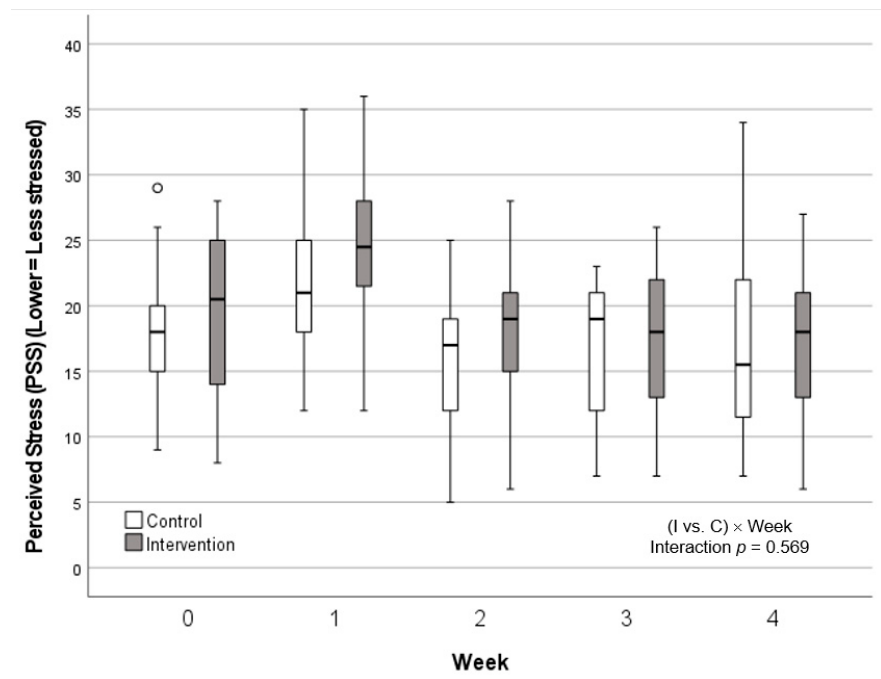
Figure 2. Perceived stress scores over time by group. For professional quality of life, boxplots of the PROQOL scores over time are given